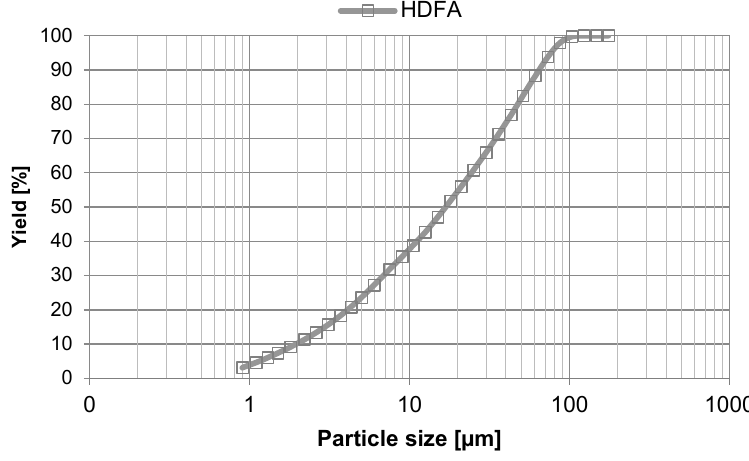
Figure 1. Particle size distribution of HDFA. Diffraction Spectrometer Helos 12 LA (Sympatec GmbH, Clausthal ‐ Zellerfeld, Germany) with a dispersing Feeder Rodos 12 SR for dry, pulverulent solids. Particle size analysis was in the range of 0.9–170 μ m. HDFA 50% comprehends particles smaller in size than 17 microns. HDFA (Figure 2) using a Jeol JSM 7000Fdevice.